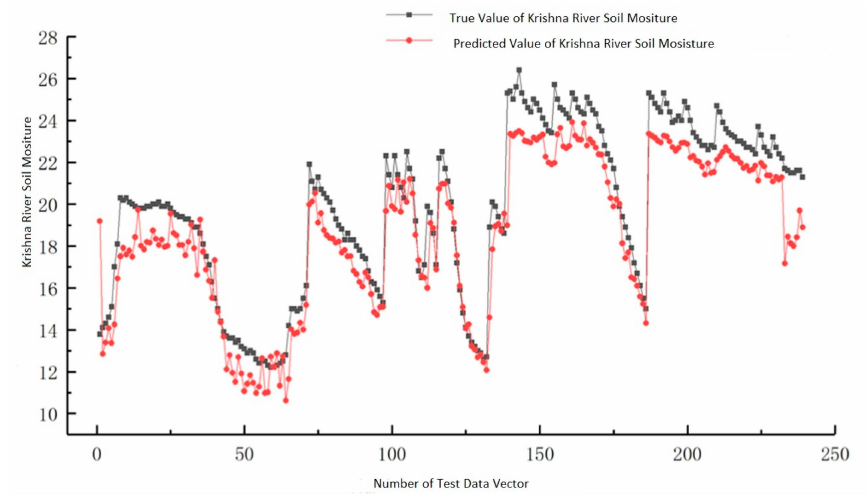
Figure 12. Future forecast of testing data–Krishna Soil Moisture Dataset.